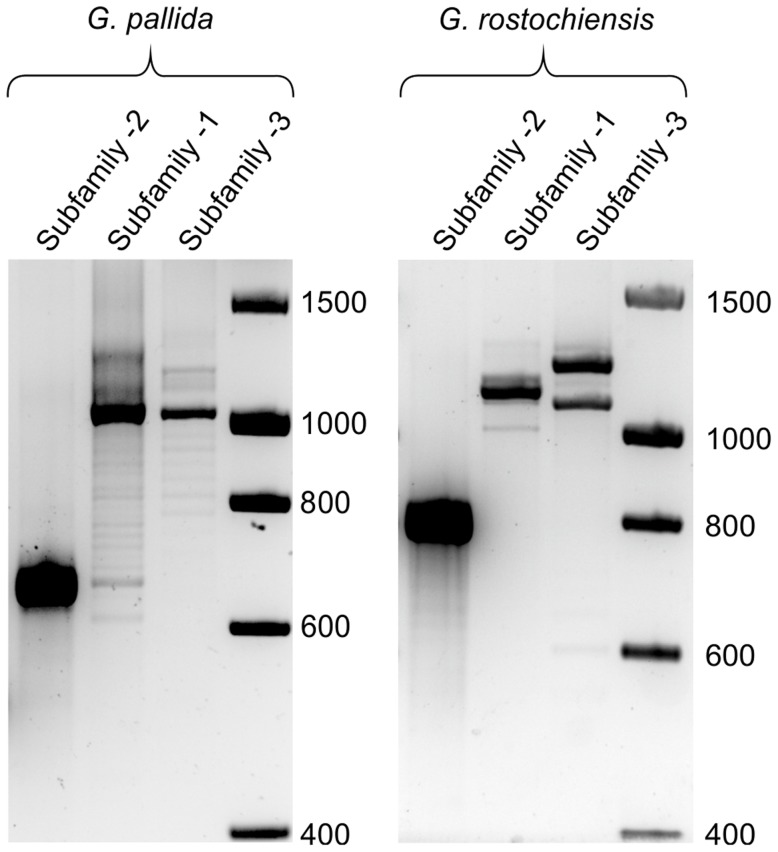
Comparison of HYP effector variation between UK populations of G. pallida and G. rostochiensis.For Gp-hyp subfamily -1 and -3 large variation can be seen when amplifying from DNA extracted from a pool of thousands of G. pallida as indicated by multiple bands. Considerably less variation is seen under the same reaction conditions for G. rostochiensis, probably reflecting a more genetically restricted introduction to the UK. Amplicons from each reaction were sequenced to confirm they correspond to HYP effectors.